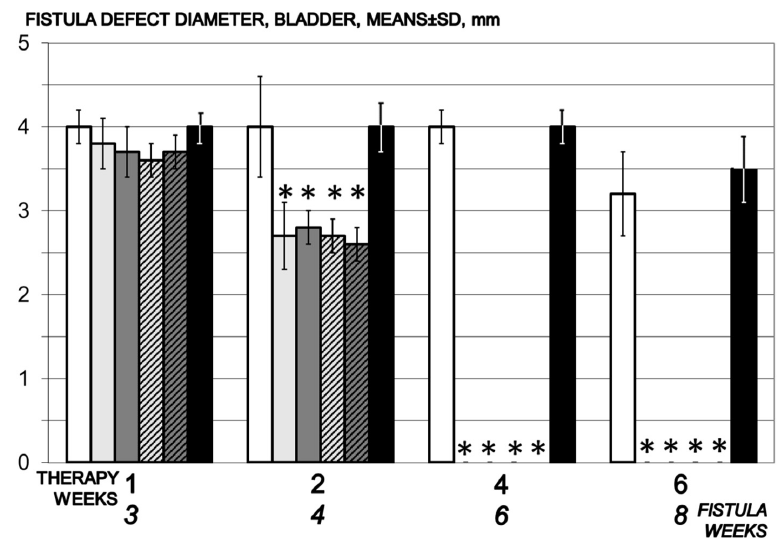
Figure 4. Bladder defect diameter, mm, means ± SD, time line. Therapy regimens starting at the day